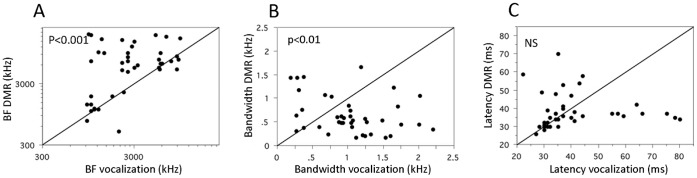
Comparison between the STRF parameters derived from the STRFvoc and the STRFdmr.A. Scattergram showing the values of the BF derived from the STRFvoc (abscissa) against the values of the BF derived from the STRFdmr (ordinates). For half of the cases, the values are similar (dots around the diagonal line) whereas for the other half, the values derived from the STRFdmr were higher than those derived from the STRFvoc. B. Scattergram showing the bandwidth values derived from the STRFvoc (abscissa) against the bandwidth value derived from the STRFdmr (ordinates). In many cases, the values were lower with STRFvoc indicating a larger bandwidth of excitatory responses when tested with vocalizations. C. Scattergram showing the latency values derived from the STRFvoc (abscissa) against the bandwidth value derived from the STRFdmr (ordinates). The latencies of the excitatory responses were often similar but, in some cases, they were lower with DMRs than with vocalizations. STRF units and scale are the same as in Figure 2.